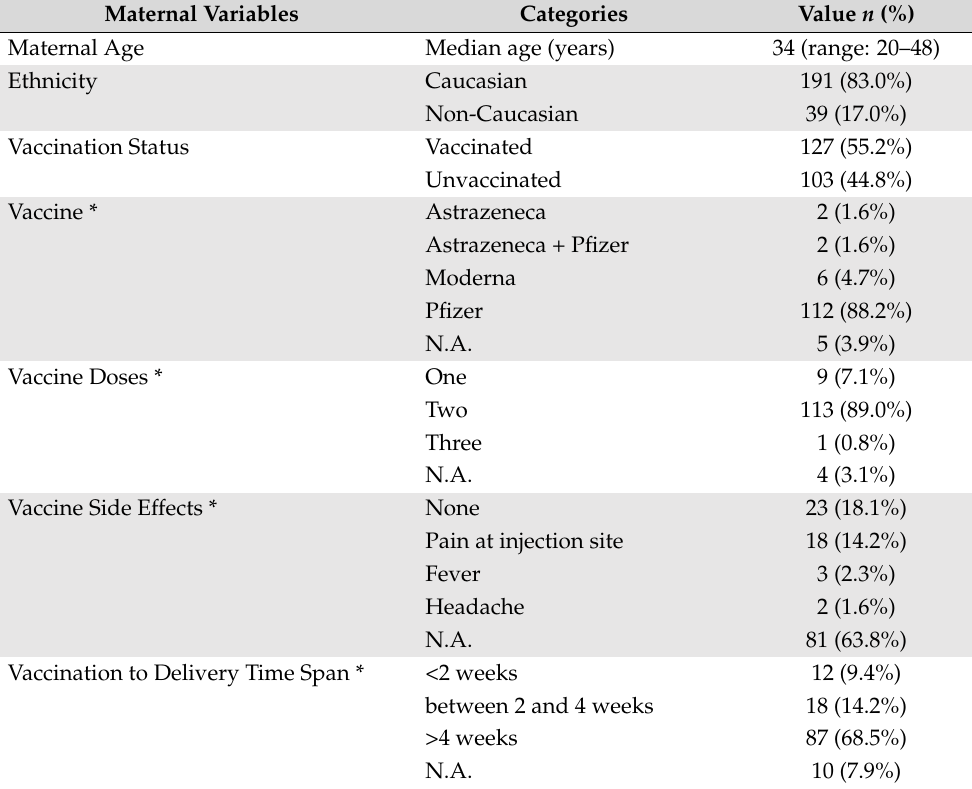
Table 1. Demographic, anamnestic and clinical features of study population.